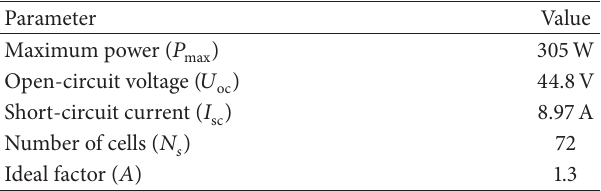
Table 1: Parameters of the PV module type CS6X-305P.